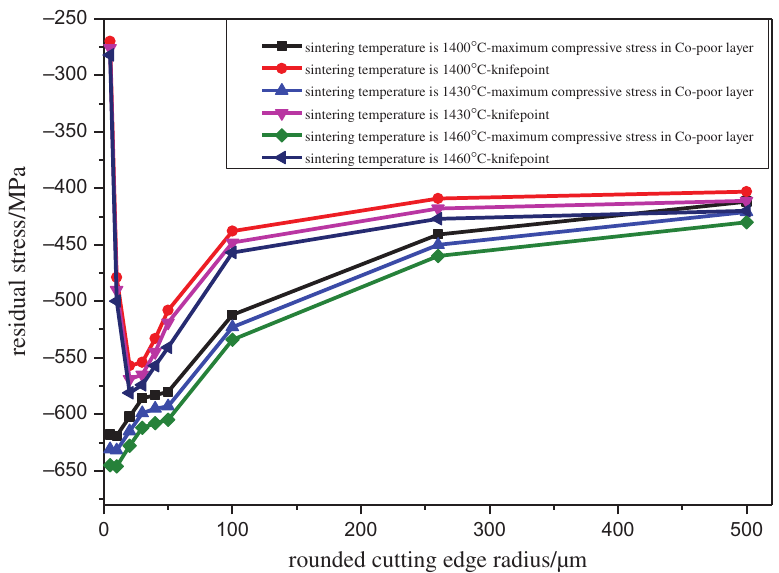
Figure 12: The effect of different rounded cutting edge radius on residual